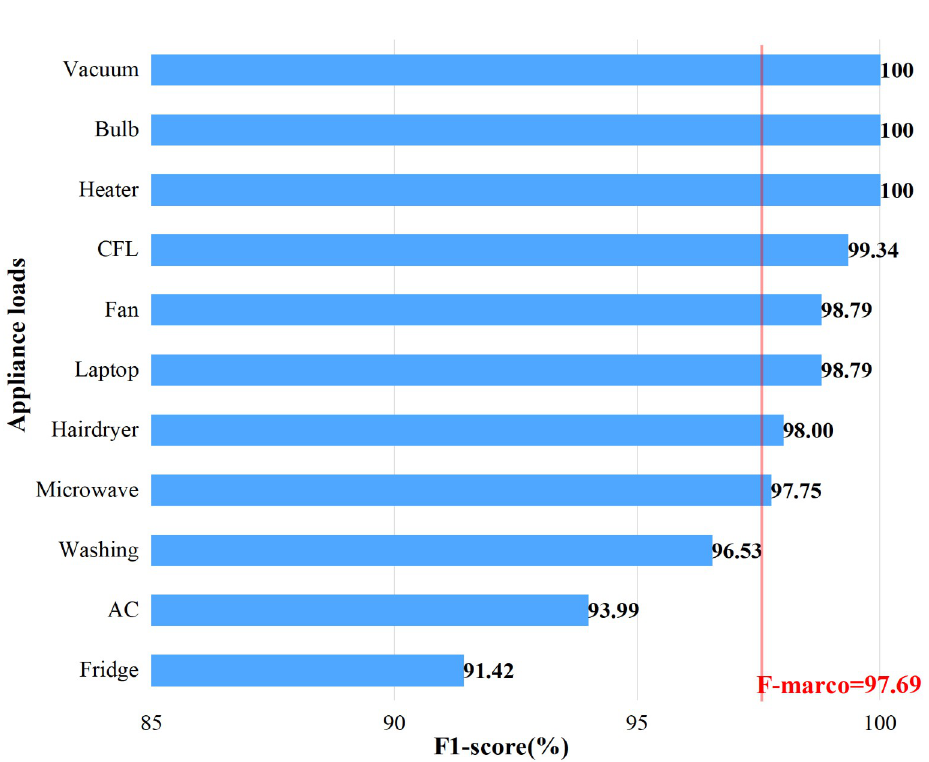
PLOS ONE | https://doi.org/10.1371/journal.pone.0281482 February 9,